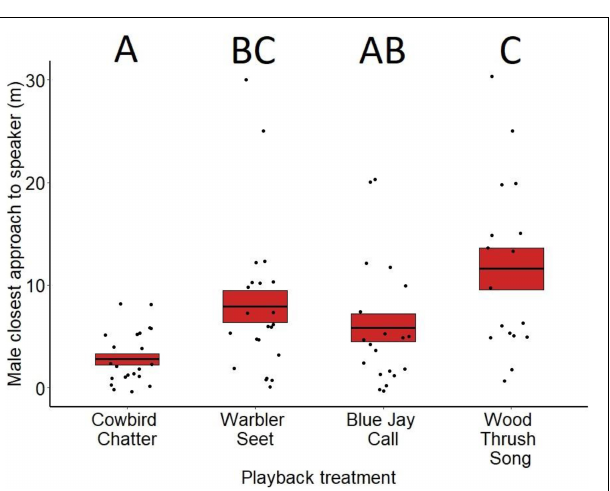
FIGURE 5 | Number of alarm calls produced by male red-winged blackbirds in response to playbacks at nests during nestling stage. Trials where males had an additional nest on territory with eggs are excluded. Means are shown with the bold line, and shaded boxes represent standard errors. Boxes with different letters denote post hoc statistical differences between treatments. For the p -values of post hoc comparisons, please refer to